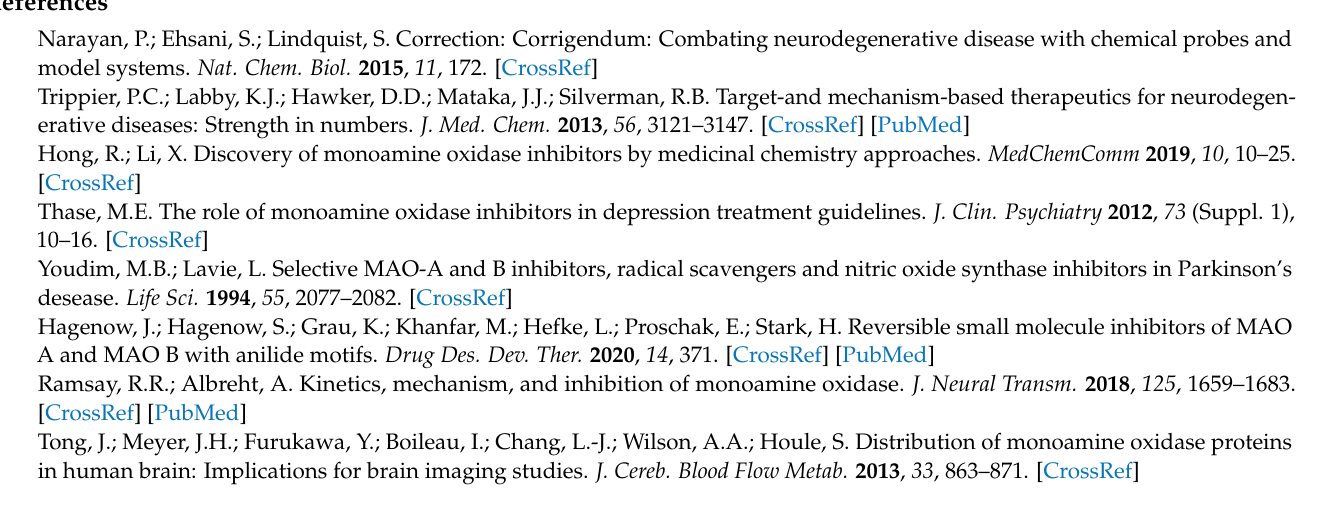
the compound 2e . Figure S22: 13 C-NMR spectra of the compound 2e . Figure S23: APCI-MS spectra of the compound 2e . Figure S24: HRMS spectra of the compound 2e . Figure S25: LCMS spectra of the compound 2e . Figure S26: 1 H-NMR spectra of the compound 2f . Figure S27: 13 C-NMR spectra of the compound 2f . Figure S28: APCI-MS spectra of the compound 2f . Figure S29: HRMS spectra of the compound 2f . Figure S30: LCMS spectra of the compound 2f . Figure S31: 1 H-NMR spectra of the compound 2g . Figure S32: 13 C-NMR spectra of the compound 2g . Figure S33: APCI-MS spectra of the compound 2g . Figure S34: HRMS spectra of the compound 2g . Figure S35: LCMS spectra of the compound 2g . Figure S36: 1 H-NMR spectra of the compound 2h . Figure S37: 13 C-NMR spectra of the compound 2h . Figure S38: APCI-MS spectra of the compound 2h . Figure S39: HRMS spectra of the compound 2h . Figure S40: LCMS spectra of the compound 2h . Figure S41: 1 H-NMR spectra of the compound 2i . Figure S42: 13 C-NMR spectra of the compound 2i . Figure S43: APCI-MS spectra of the compound 2i . Figure S44: HRMS spectra of the compound 2i . Figure S45: LCMS spectra of the compound 2i . Figure S46: 1 H-NMR spectra of the compound 2j . Figure S47: 13 C-NMR spectra of the compound 2j . Figure S48: APCI-MS spectra of the compound 2j . Figure S49: HRMS spectra of the compound 2j . Figure S50: LCMS spectra of the compound 2j . Figure S51: 1 H-NMR spectra of the compound 2k . Figure S52: 13 C-NMR spectra of the compound 2k . Figure S53: APCI-MS spectra of the compound 2k . Figure S54: HRMS spectra of the compound 2k . Figure S55: LCMS spectra of the compound 2k . Figure S56: 1 H-NMR spectra of the compound 2l . Figure S57: 13 C-NMR spectra of the compound 2l . Figure S58: APCI-MS spectra of the compound 2l . Figure S59: HRMS spectra of the compound 2l . Figure S60: LCMS spectra of the compound 2l